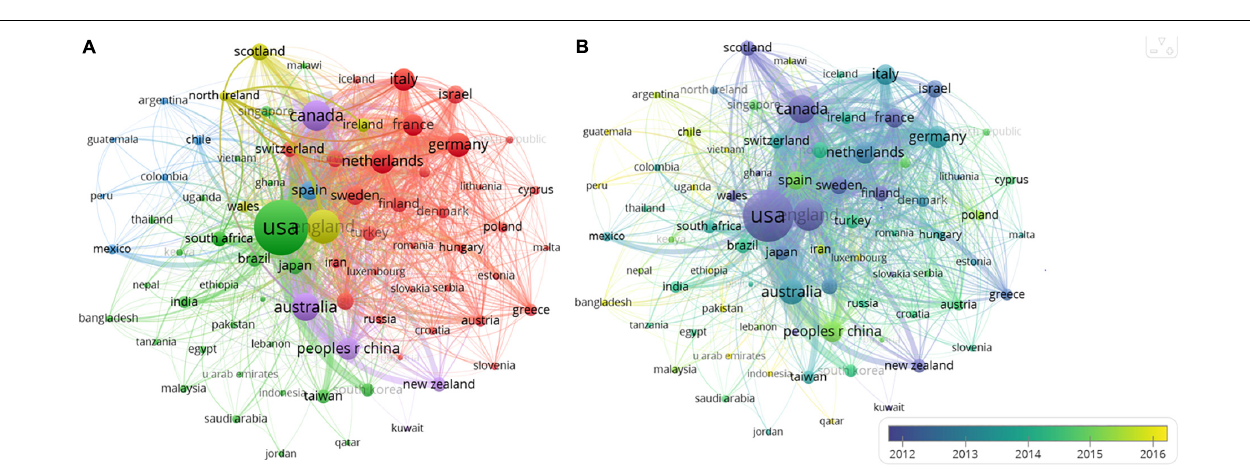
four distinct clusters. By analyzing the four cluster major nodes, each cluster can be assigned an appropriate